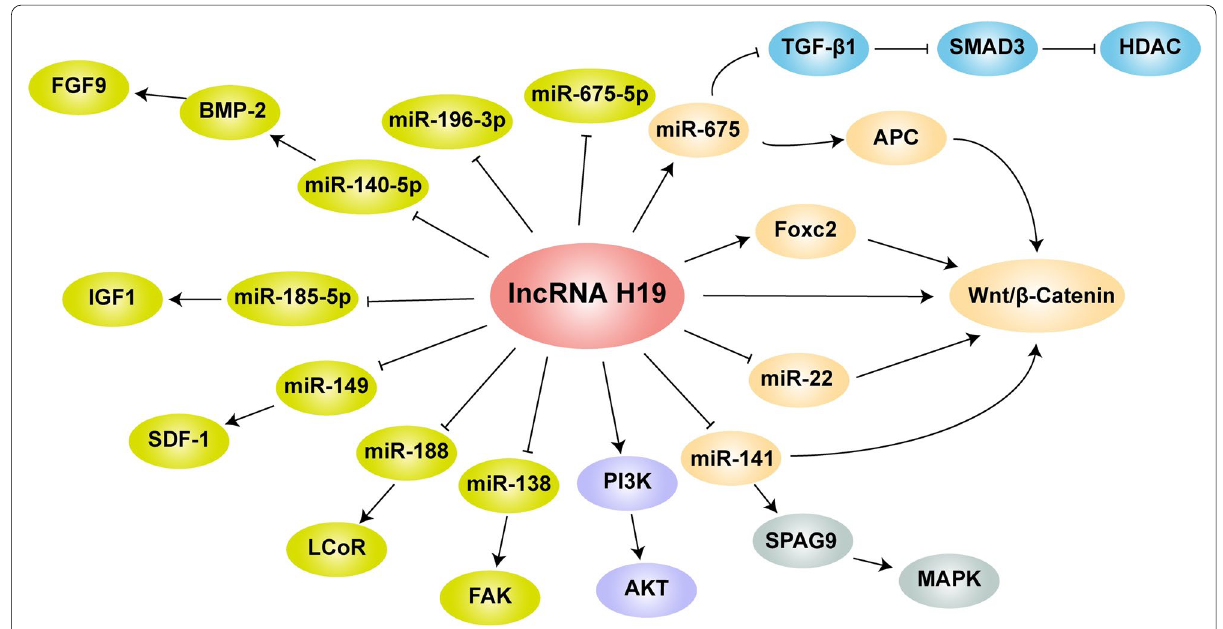
Fig. 1 The pathways and mechanisms of lncRNA H19 promoting osteogenic differentiation reported in previous published